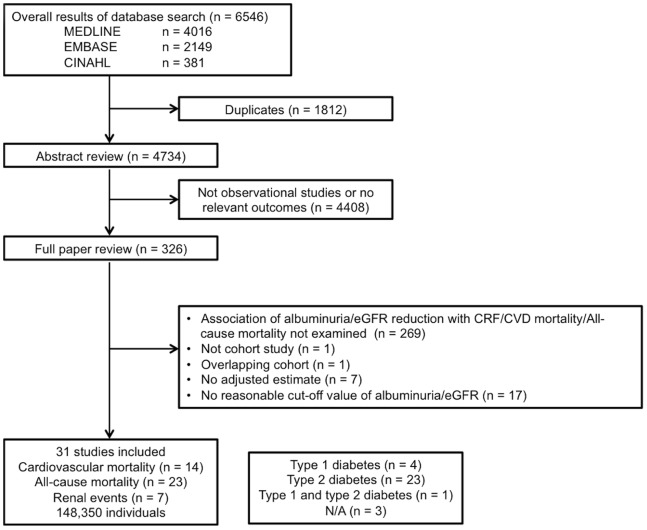
Process for identification of eligible studies Abbreviation: N/A, not available.